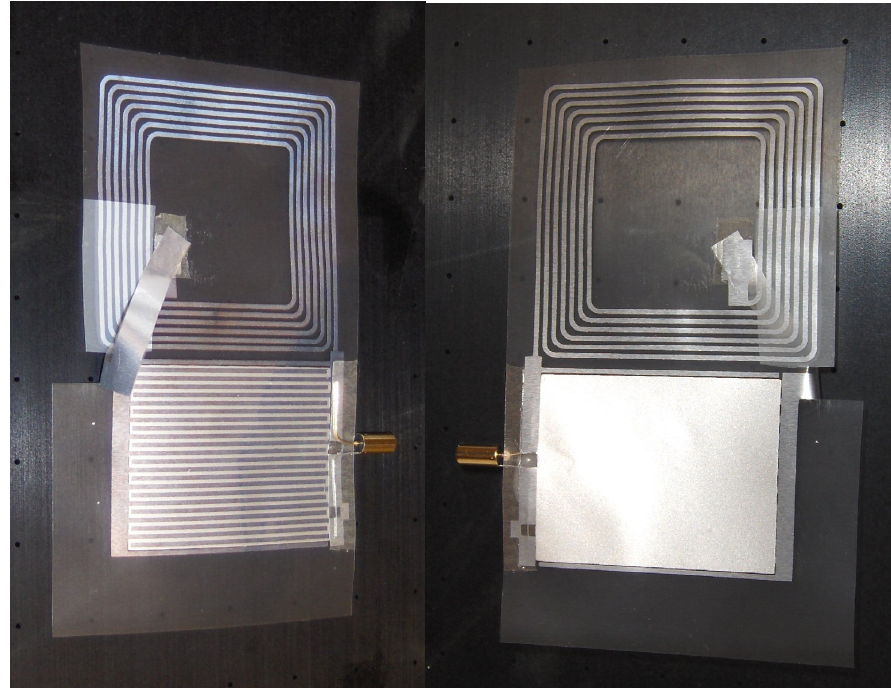
Figure 6. Photos of interdigital LCCR EAS tags manufactured in aluminum on PET with tilt sensor, frontside, left and reverse side with printed screen paste,